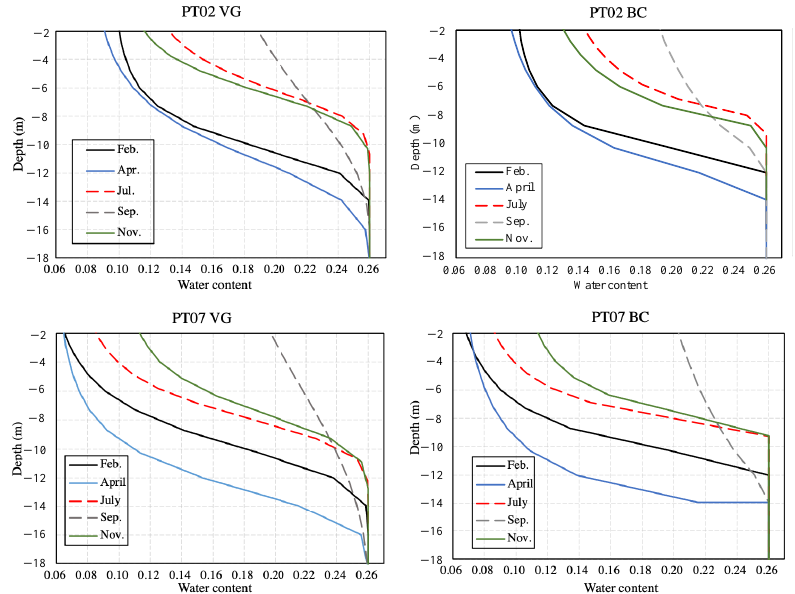
Figure 11. The Van Genchten (VG) and Brooks–Corey (BC) for PT02 and PT07 sites for five different months. The dashed curve corresponds to the wet season while the solid curve represents the dry season.